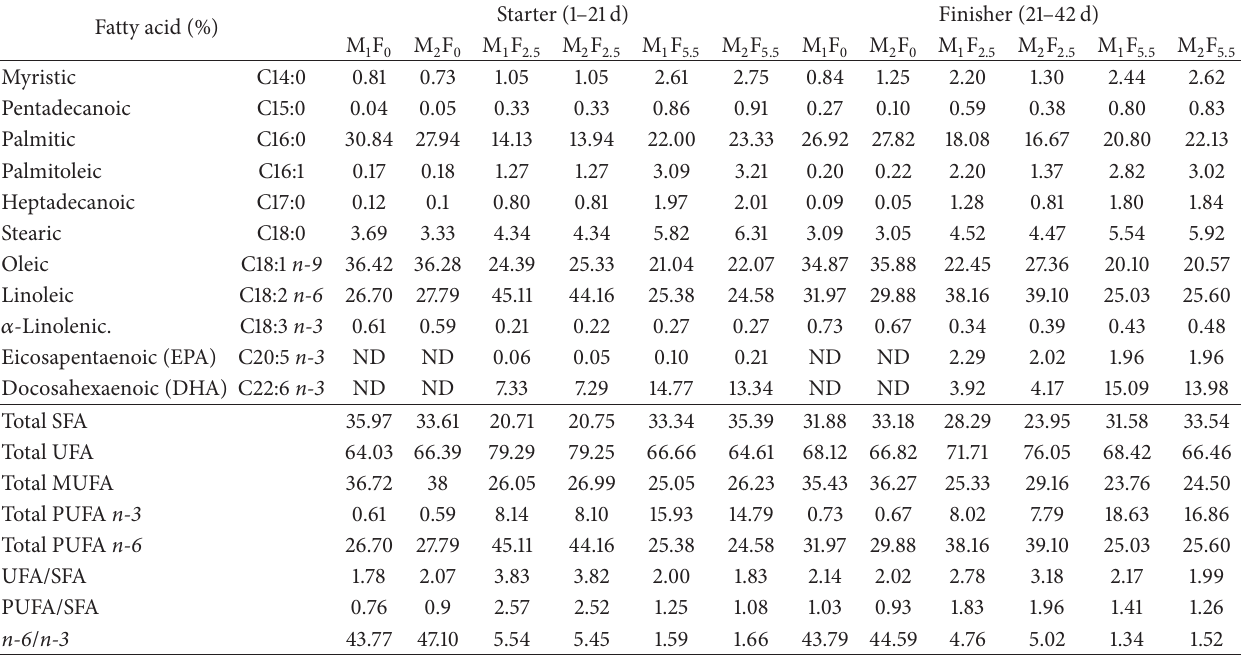
Table 2: Fatty acid compositions of treatment diets.